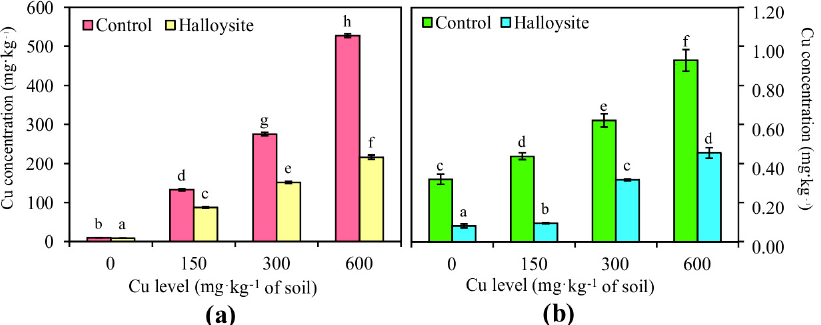
Figure 6. Total ( a ) and CaCl 2 -extractable ( b ) Cu fractions in soil with the different soil treatments (mean ± SD, n = 3). Values in columns marked with the same letter do not differ significantly (Duncan’s test, p > 0.05).